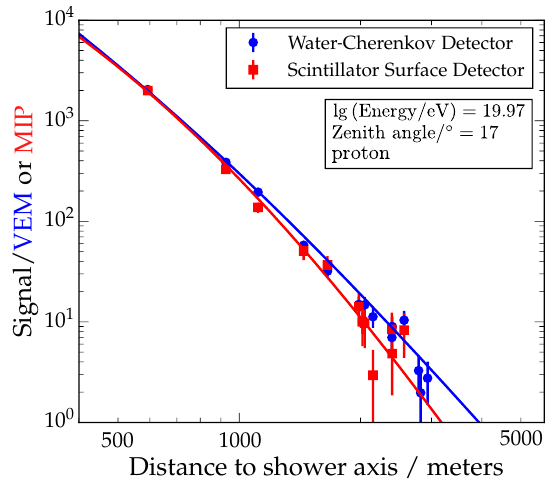
Figure 6. Simulated signals of SSDs alongside partner WCDs for various samples of the lateral distribution of the particles reaching ground in a simulated